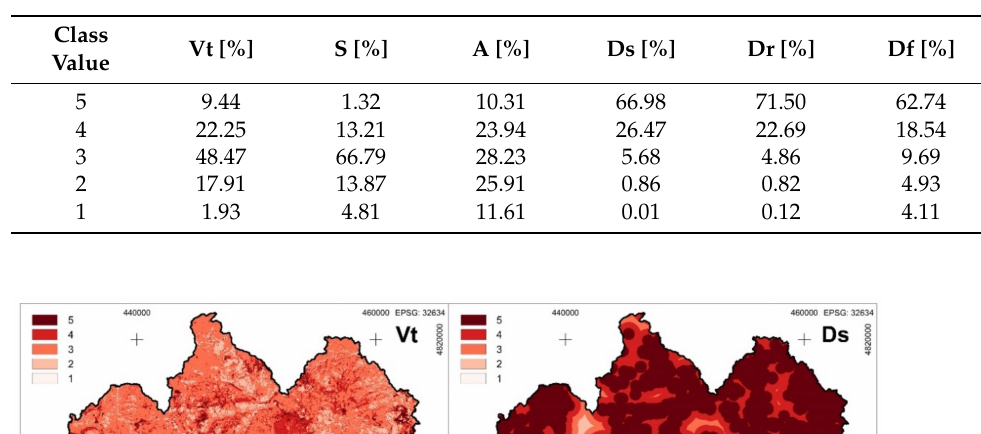
Table 5. Distribution of classes in factors in the total Nature Park Golija territory.